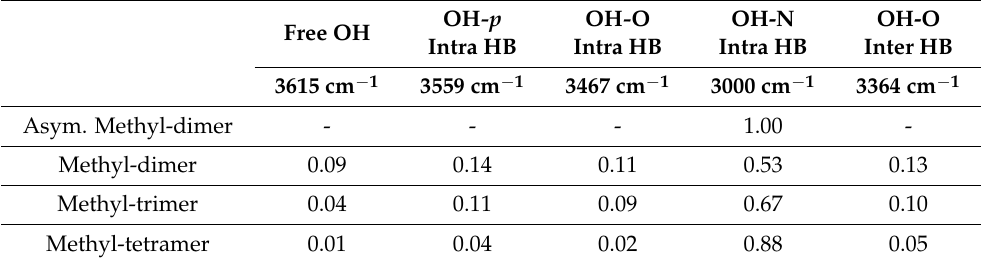
Table 5. Fraction of various hydrogen bonded species for different sizes of benzoxazine oligomers in 50 mM CCl 4 solutions [411].